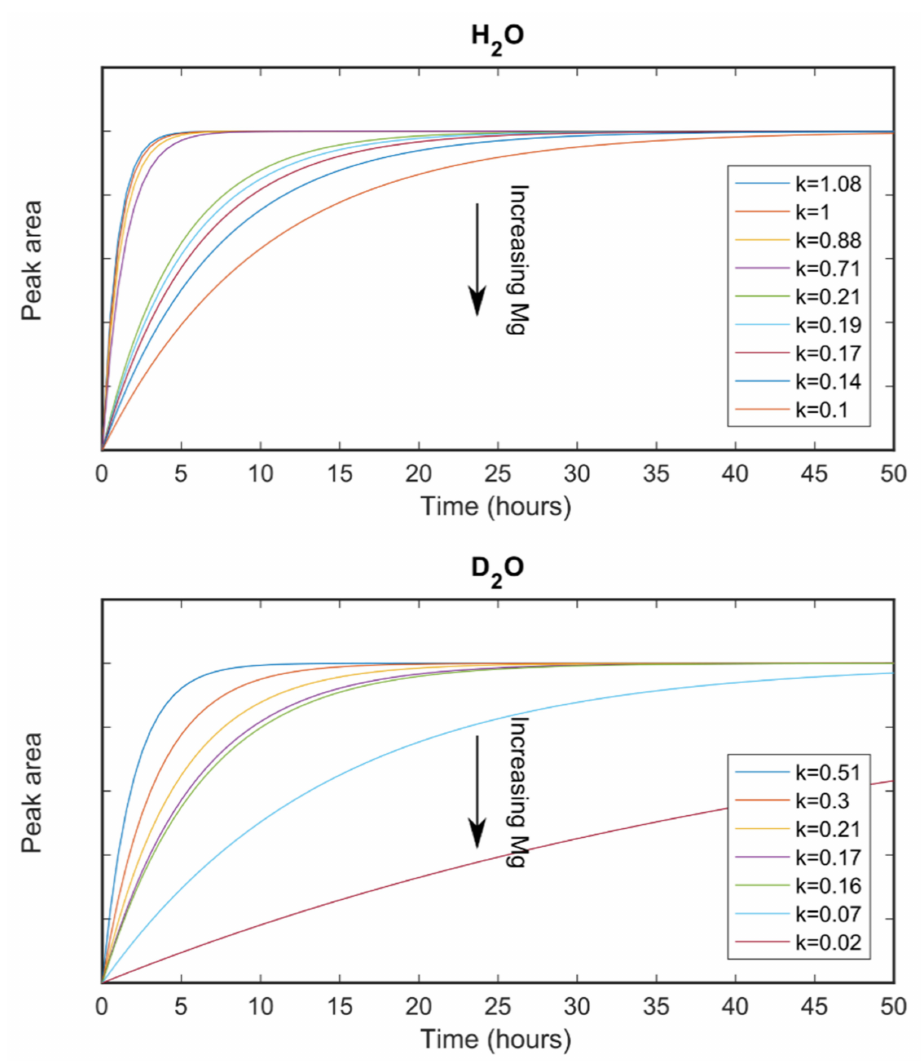
Figure 6. Compilation of the degree of aragonite formation as a function of magnesium content for samples formed from ACC with varying Mg/Ca ratios using H 2 O and D 2 O as the